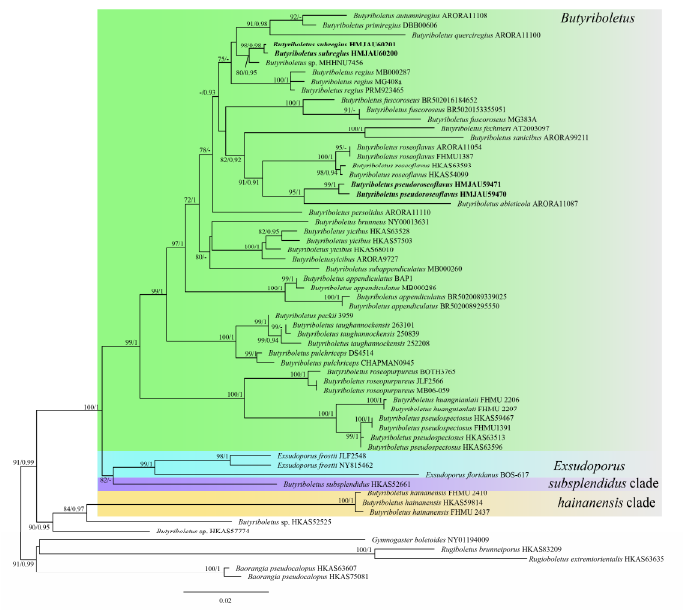
Figure 2. Phylogenetic analysis of Butyriboletus inferred from ML analysis. BP value (>70) and PP value (>9) are shown around branches. Our new species sequences are indicated in